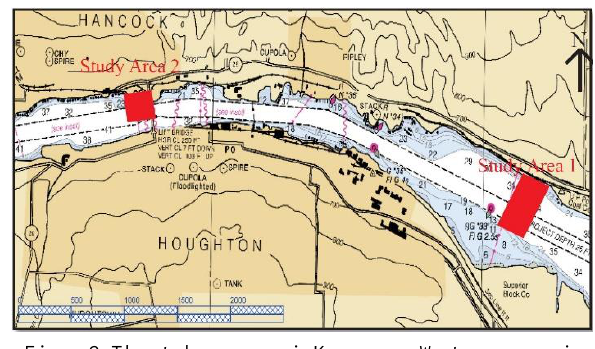
Figure 2. The study areas are in Keweenaw Waterway map in Michigan, USA including Houghton and Hancock (Base Map